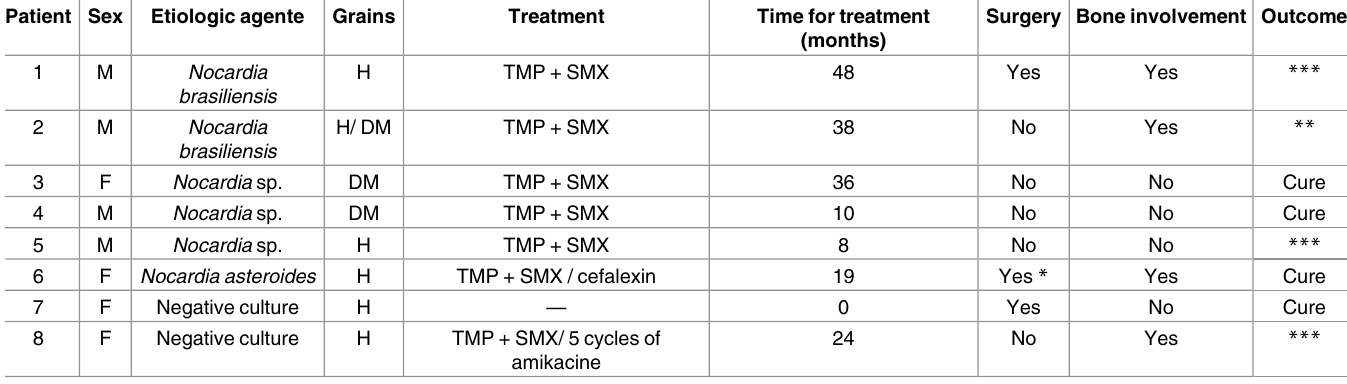
Table 3. Main characteristics of 8 patients with